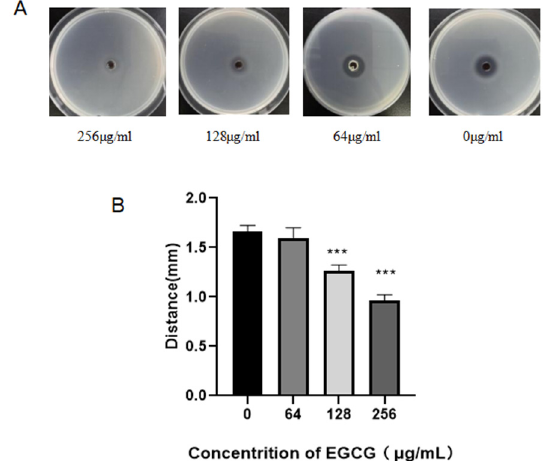
Figure 6. Concentration-dependent inhibition effects of EGCG on elastase activity in P. aeruginosa . ( A ). Using Skim milk agar plates to detect elastase activity. ( B ). The distance of transparent zones